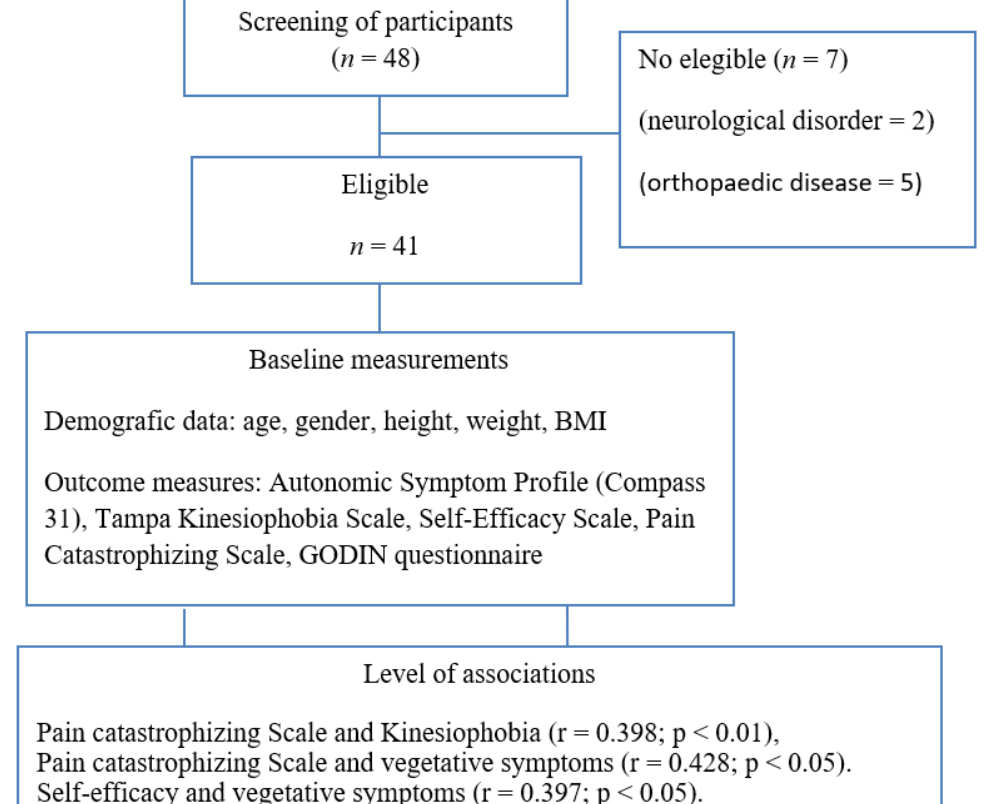
Figure 1. Flow diagram of